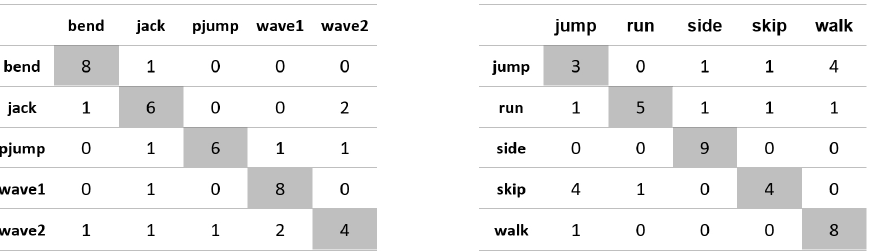
Figure A2. Confusion matrices for the experiment using the ‘lower-occlusion’ database, elongation and Euclidean distance.